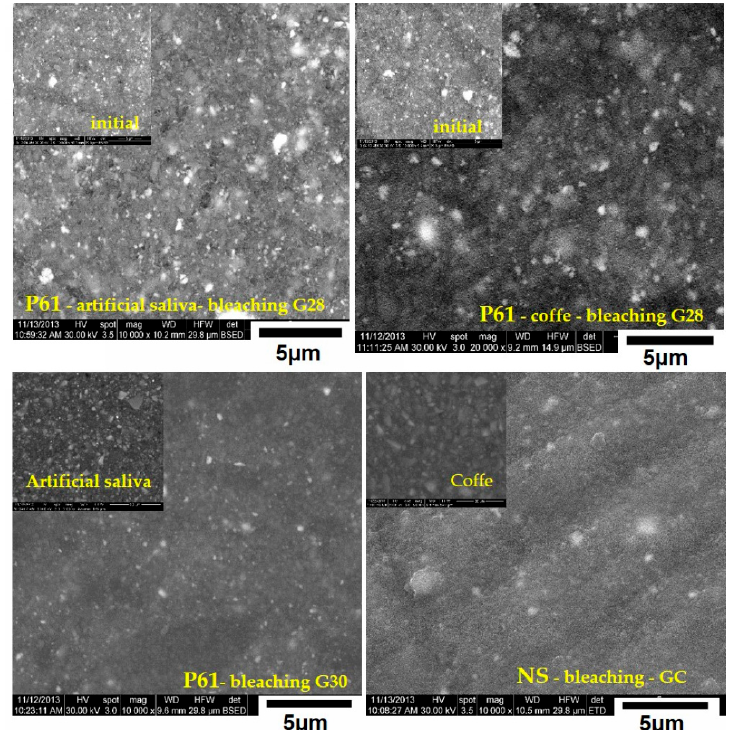
Figure 6. SEM images for experimental composite materials ( a ) P11—image left top of the original sample, large image is G28 bleached composite after storage in artificial saliva for 30 days; ( b ) P61—image left top of the original sample, large image is G29 bleached composite after storage in coffee; ( c ) P61—image the left top of the original sample, large image is G30 bleached composite after storage in artificial saliva; ( d ) Nanofill—image in the left top of the original sample, large image is GC commercial gel bleached composite after storage in the coffee.